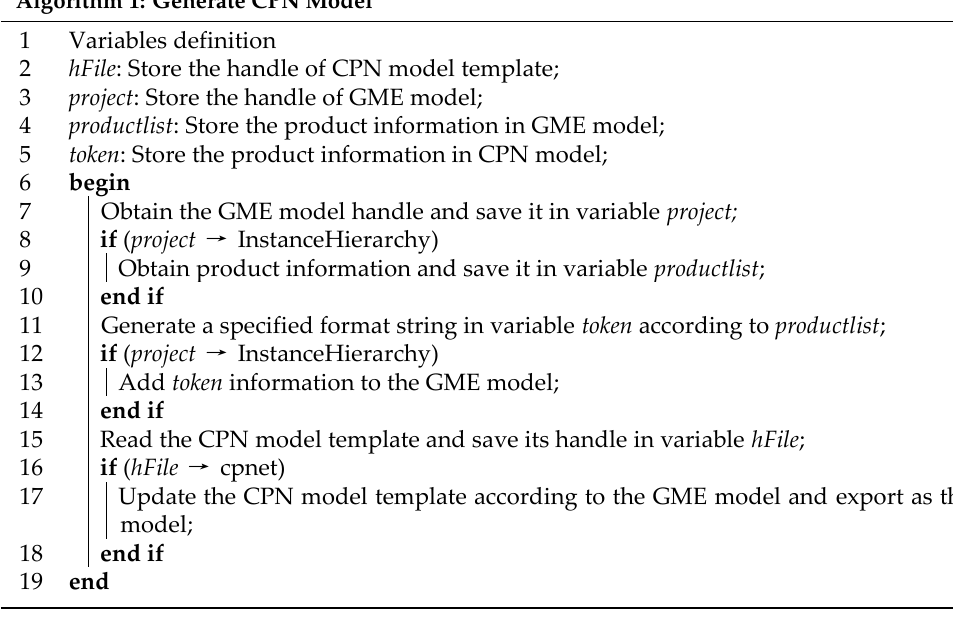
Figure 3. Intelligent factory experiment platform system configuration. 4.1. Hardware Distribution and Network Composition The experimental platform’s hardware and network consist of the following compo- nents: (1) a number of intelligent pallets capable of real-time interaction with the private cloud; (2) nine workstations offering different processes and six intelligent